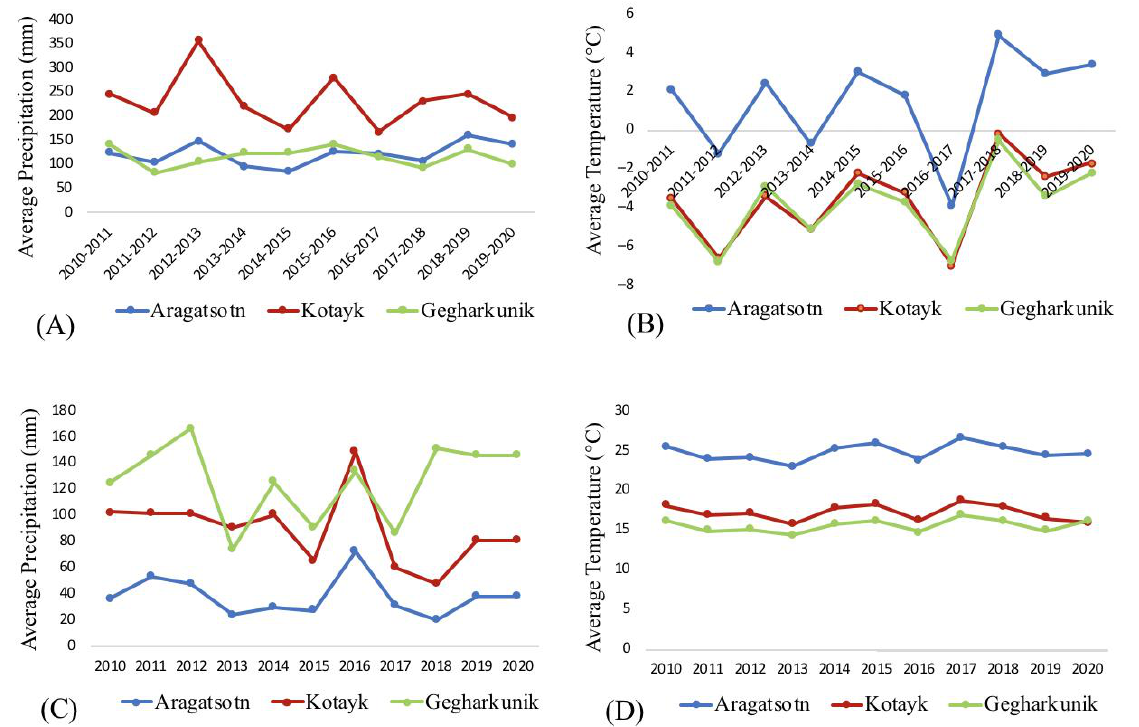
Figure 8. Total precipitation and average temperature during winter ( A , B ) and summer ( C , D ) periods in the selected regions of Aragatsotn, Gegharkunik and Kotayk in 2010 – 2020. Changes in the distribution of B. corolliflora in terms of alterations of the growth area and density of the population were observed, though generally being less drastic com- pared to B. lomatogona. Originally being predominant in humid areas at the altitudes of 2000 – 2700 [27], B. corolliflora was also found at 1400 – 2360 m a.s.l. [28,39]. It should be men- tioned that records of the species at the low altitudes by roads may not be considered as species ’ natural habitats, as they were likely dispersed to the lower areas by humans. We showed here that in the selected location the species was preserved at the same altitude during 2016 – 2021. However, as a general observation, B. corolliflora has been found re- cently at ca. 100 – 150 m lower altitudes than in the 1980s (Table 1). Precipitation and temperature irregularities have more pronounced effects in arid and cold biomes than in wet and temperate ones [36]. The climate in Kotayk is cooler and more humid compared to Aragatsotn (Figure 2). The gradual temperature increase of around 1.7 °C observed since 2011 (Figure 9B) in the Kotayk region possibly sustained plant growth and development and might also have supported the migration of the spe- cies from upper to middle mountain belts. The reduction of the average annual precipita- tion in 2017 – 2020 (Figure 9B) could have been detrimental for the species [36]. However, the high precipitation level in December – March of 2017 – 2019 and slightly cooler summers in 2019 – 2020 (Figure 8AD, Table S1AB) have probably mitigated the adverse impact of the increasing drought [40,41]. We also suggest that the changes in the distribution of B. corol- liflora during the past several years were not associated only with the changing climate. Hrazdan region is a heavily exploited zone with intensive agriculture and increased ur- banization, so the involvement of the anthropogenic factors should be seriously consid- ered [42,43].